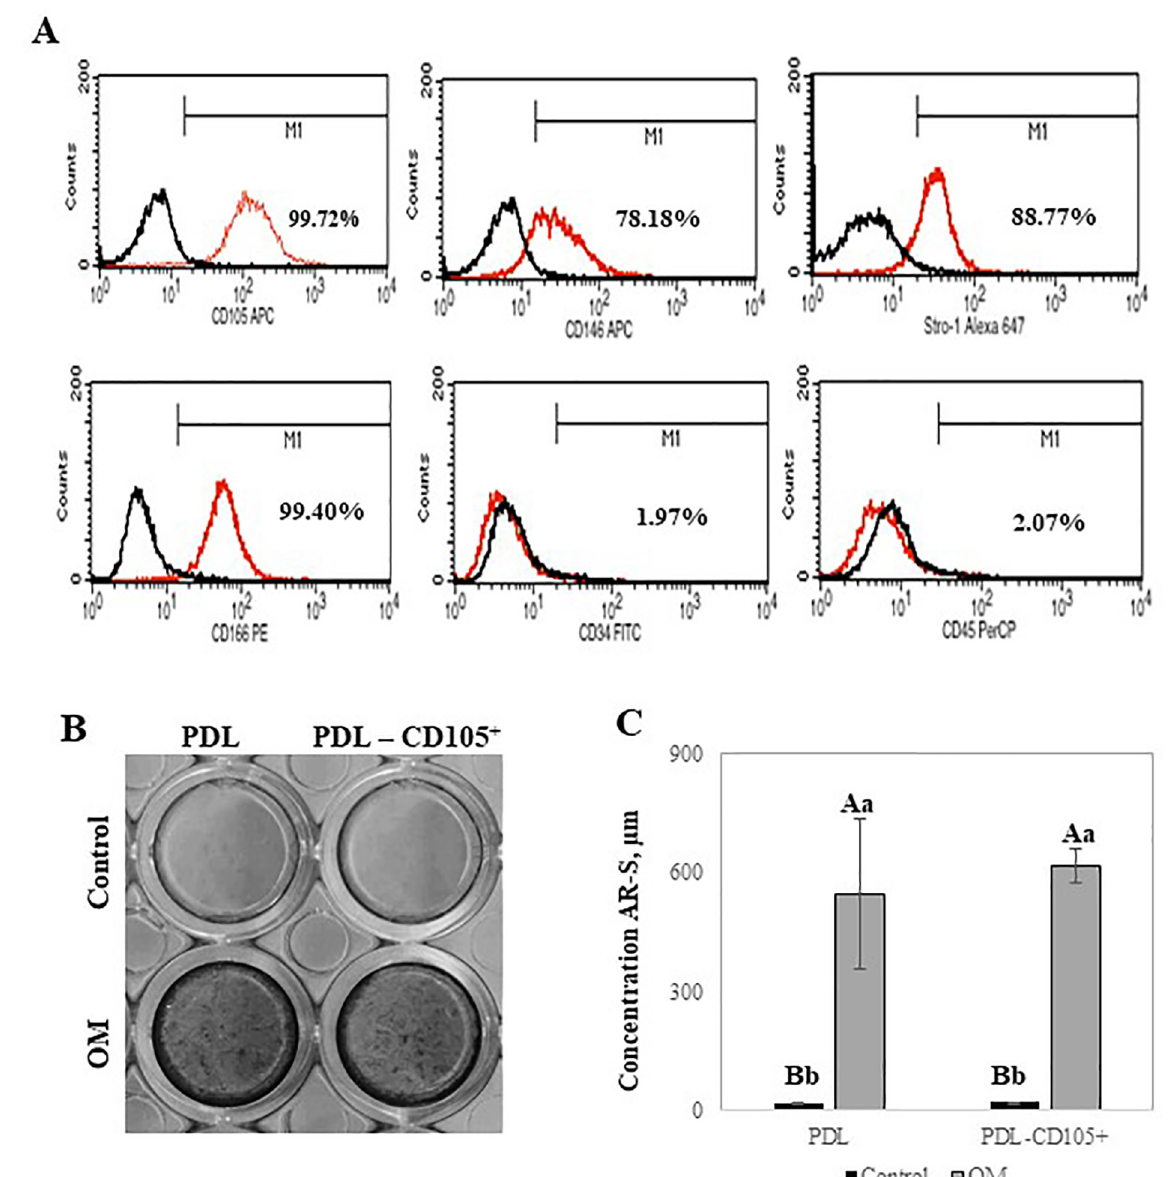
Figure 1- Periodontal ligament derived (PDL) CD105+-enriched population characterization. (A) Flow cytometric analysis of PDL- CD105+-enriched population. The relative levels of cell surface expression were analyzed using CD105, CD146, CD166, STRO-1, CD34 and CD45 antibodies (red histograms) and their isotype-matched antibodies as control (black histograms). (B) Alizarin Red Stain (AR- S) assay demonstrated that PDL-CD105+-enriched population showed similar potential of biomineralization as the unsorted population (PDL) when cultivated under osteogenic induction (OM). (C) Quantification AR-S showed that both PDL-CD105+-enriched population and unsorted PDL presented significant increase of AR-S when cultivated in OM comparing control medium. Bars in (C) represent mean ± standard deviation (SD), in which intragroup statistical differences analysis are indicated by distinct capital letters, and intergroup statistical differences analysis are indicated by distinct lowercase letters. Statistical significance was determined using Two-way ANOVA/Tukey’s test